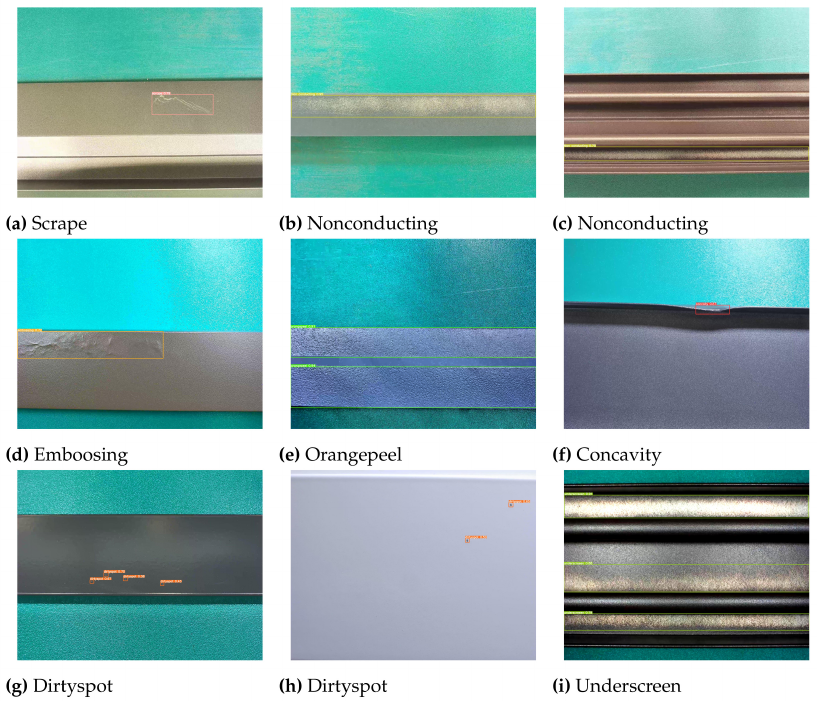
Figure 13. MS-YOLOv5 results for seven different